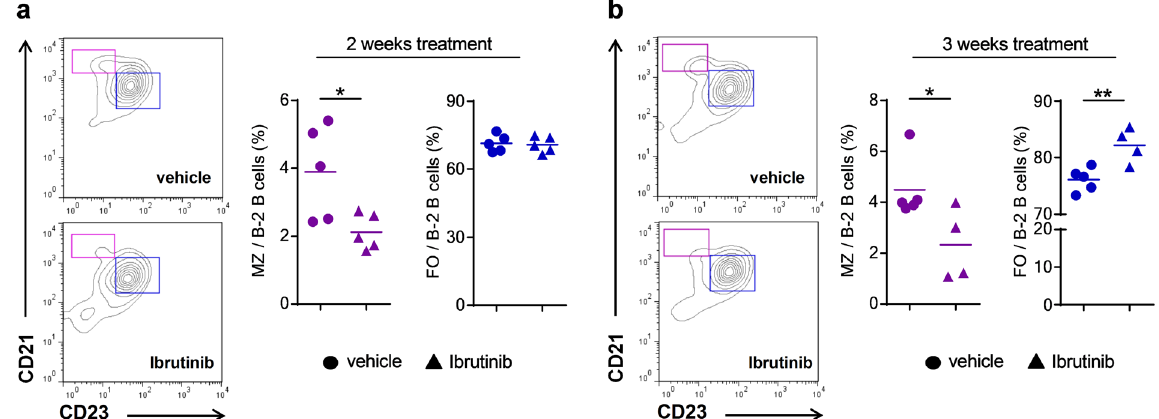
Figure 3. Ibrutinib treatment limits MZ and favors FO B cell development in sIgM + / + mice in vivo . Representative flow cytometry plots and dot plots represent the frequencies of MZ (purple) and FO (blue) B cells within B-2 cells of sIgM + / + mice treated with vehicle ( ● ) or the Btk inhibitor Ibrutinib ( ▲ ) for ( a ) 2 weeks or ( b ) 3 weeks. All results show mean ± SEM, n = 4–5 mice per group. * P < 0.05, ** P < 0.01 (unpaired t test).